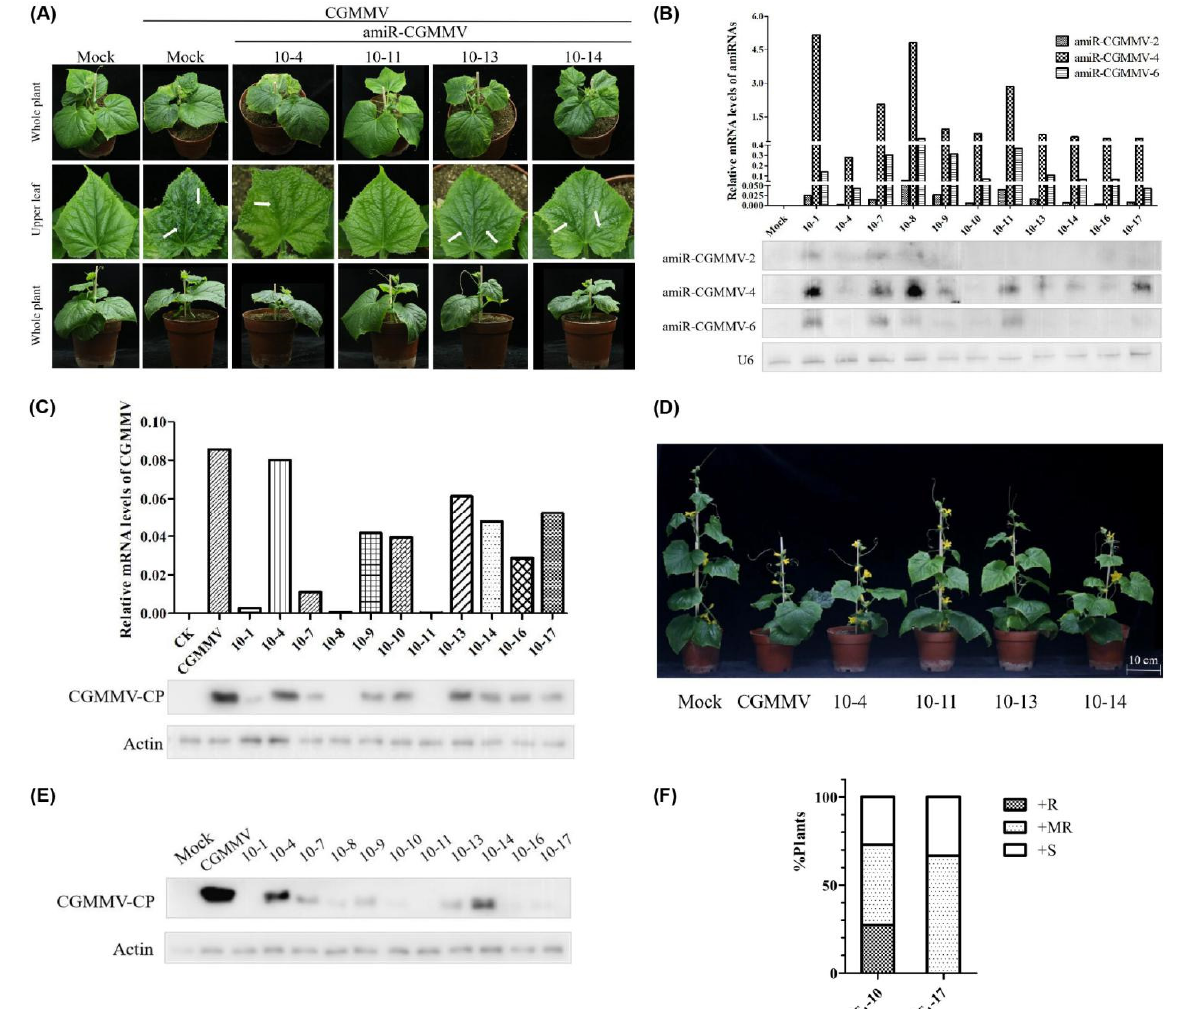
Figure 7. Assessment of CGMMV resistance in transgenic cucumber lines expressed polycistronic amiR246. ( A ) Symptoms on transgenic cucumber plants at 20 dpi; CGMMV-induced typical leaf mild mottle and mosaic are indicated by white arrows. ( B ) Expression of amiR246 in different transgenic cucumber lines detected by Northern blot and qRT-PCR. ( C ) Detection of CGMMV level in transgenic lines by specific qRT-PCR assays (upper) and Western blot hybridization (lower) at 20 dpi. ( D ) Phenotypes of transgenic and control plants after CGMMV infection at 40 dpi. ( E ) Detection of CGMMV accumulation in transgenic plants by Western blot at 40 dpi. ( F ) Western-blot-based bioassay analysis of resistance in segregating populations. +S indicates polycistronic amiR246 transgene-carrying susceptible segregants, +MR indicates transgene-carrying moderately resistant segregants, and +R indicates transgene-carrying resistant segregants. qRT-PCR, quantitative reverse transcription-polymerase chain reaction. amiR-CGMMV, the positive transgenic lines containing the polycistronic amiRNA